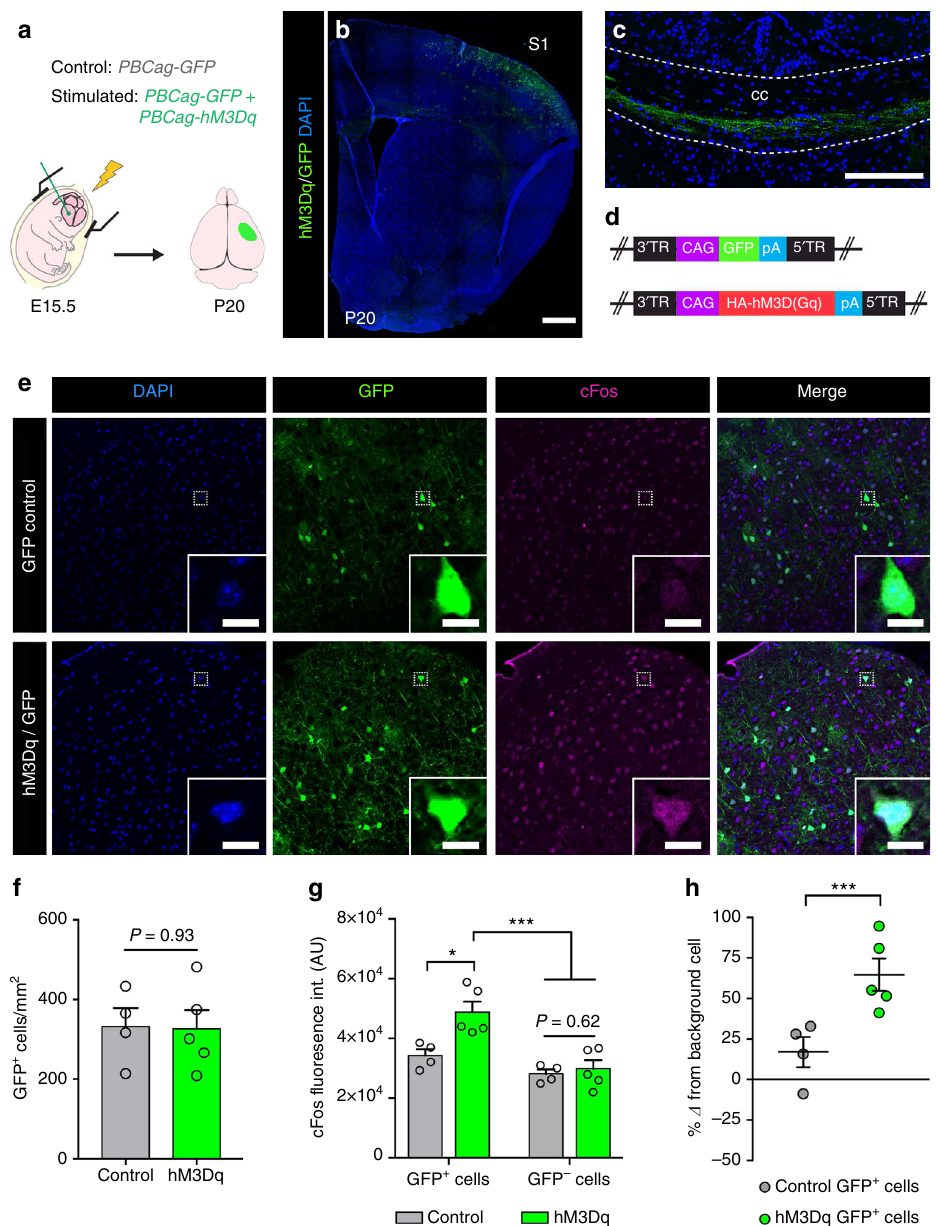
Fig. 1 DREADD-mediated neuronal stimulation results in increased cFos expression. a – c PBCag-GFP (GFP control) or a 1:1 combination of PBCag-GFP and PBCag-hM3Dq (hM3Dq/GFP) were electroporated unilaterally into the right cerebral neuroepithelium of CD1 mice at E15.5 ( a ), resulting in a highly stereotypical and reproducible expression pattern in layer 2/3 S1 pyramidal neurons ( b ) and their axonal projections in the corpus callosum at P20 ( c ). d Structure of the PiggyBac plasmids encoding hM3Dq and Gfp that were used. e Representative images showing cFos expression in the S1 cortex of GFP control (top panel) and hM3Dq/GFP (bottom panel) mice following a week of CNO administration (P19 – 26). f Plasmid electroporation ef fi ciency was similar between hM3Dq/GFP and GFP control mice. g The normalized absolute intensity of cFos immunostaining was signi fi cantly increased in hM3Dq/ GFP electroporated neurons compared to that of GFP controls or non-electroporated neurons following a week of CNO-mediated stimulation (AU, arbitrary units). h Graph depicting the percentage change in cFos normalized absolute intensity from the average GFP − cell intensity within samples. Welch ’ s corrected unpaired two-tailed t -test: * P < 0.05, *** P < 0.001; n = 6 mice/group, ± s.e.m. Scale bars = 500 µ m ( b ), 200 µ m ( c , e ), 10 µ m (insets, e ). See also Supplementary Fig.